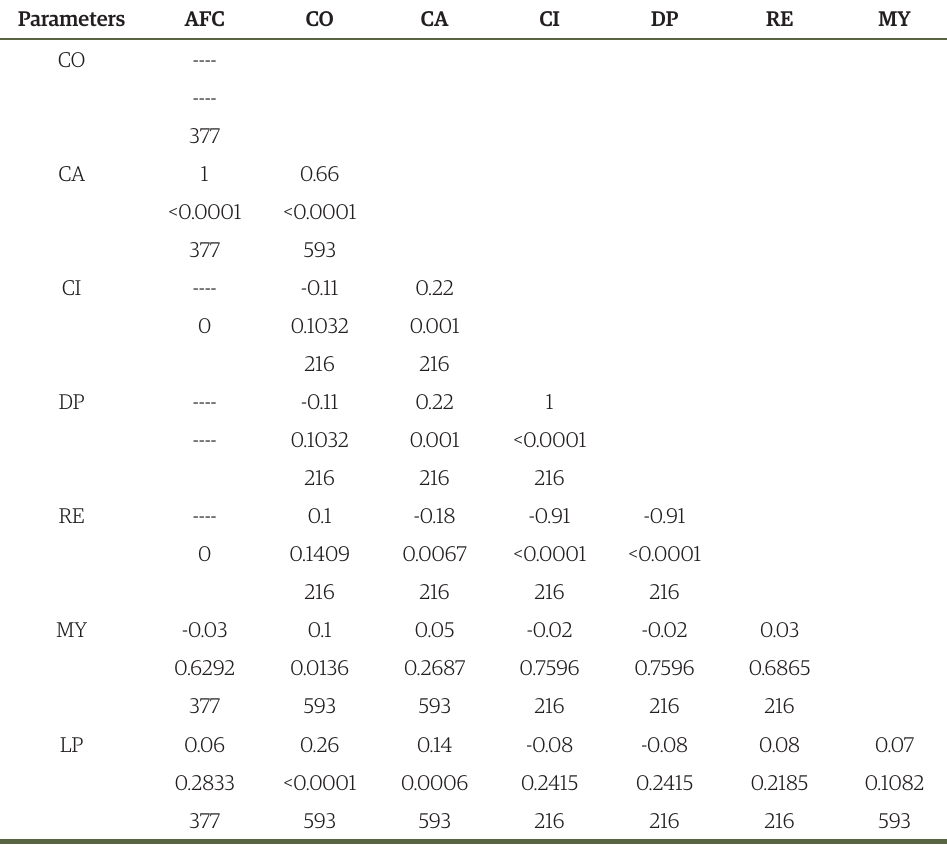
Table 4. Statistical significance and relationship between the following parameters: age at first calving (AFC), calving order (CO), calving age (CA), calving interval (CI), dry period (DP), reproductive efficiency (RE), milk yield (MY) and lactation period